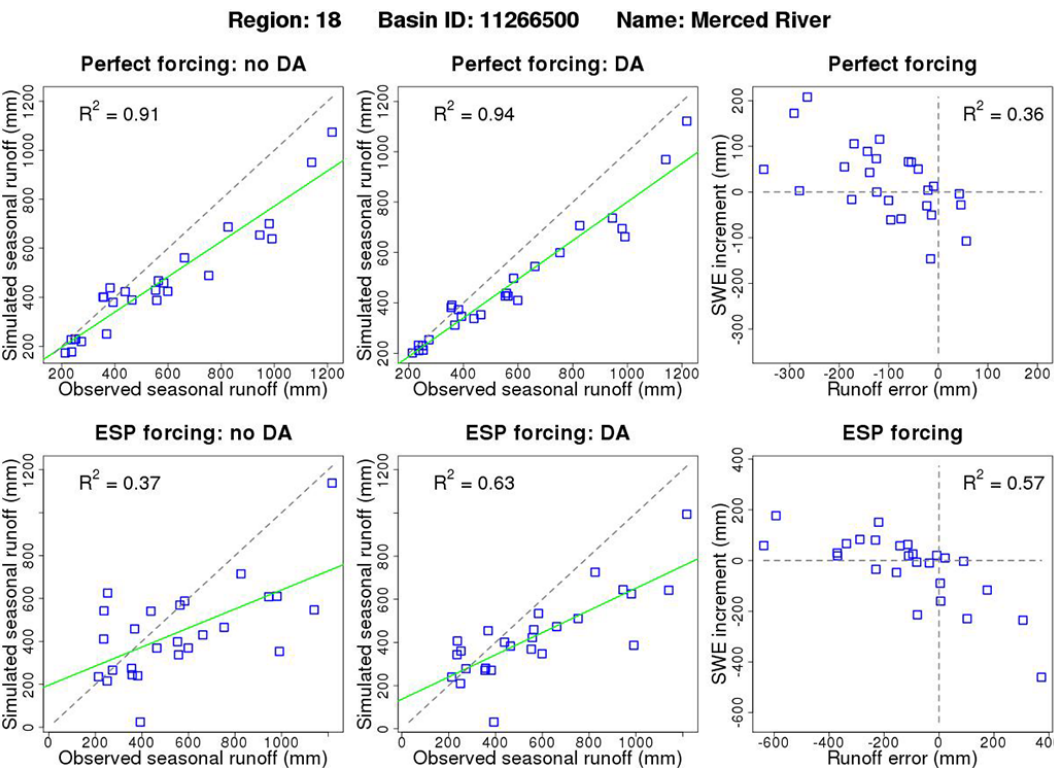
Figure 13. Scatterplots for seasonal runoff and SWE on the DA date for the Merced River (same as Fig.